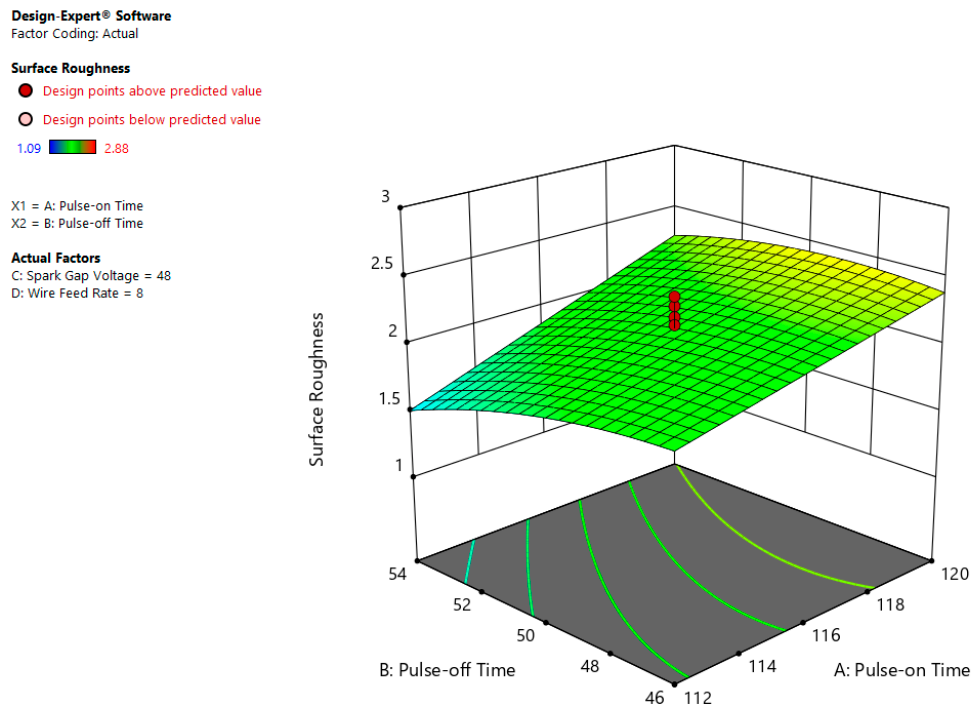
Figure 11. Correlation influence of Ton and Toff on SR.